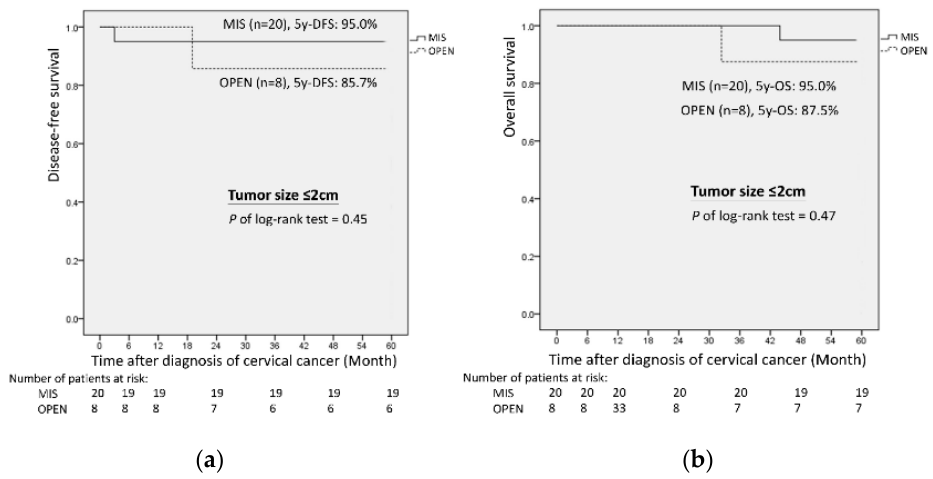
Figure 2. Oncologic outcomes of MIS versus open radical hysterectomy with pathologic tumor size ≤ 2 cm: ( a ) 5-year disease-free survival; ( b ) 5-year overall survival.